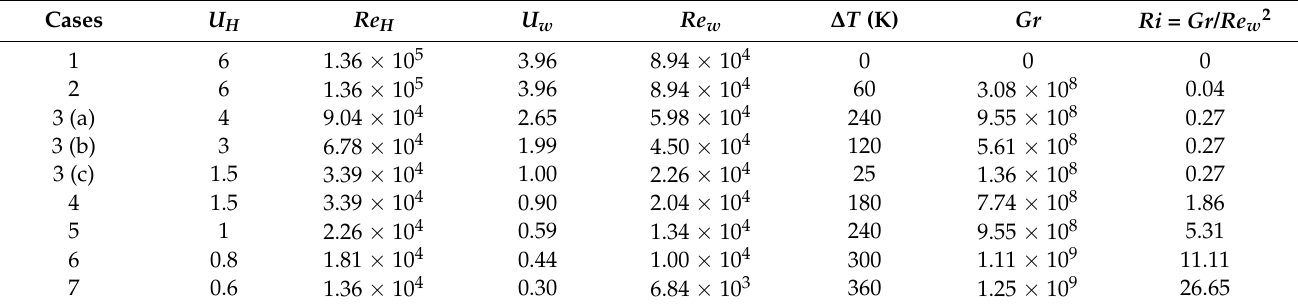
Table 1. The Ri cases studied under cross-ventilation conditions for reduced-scale physical